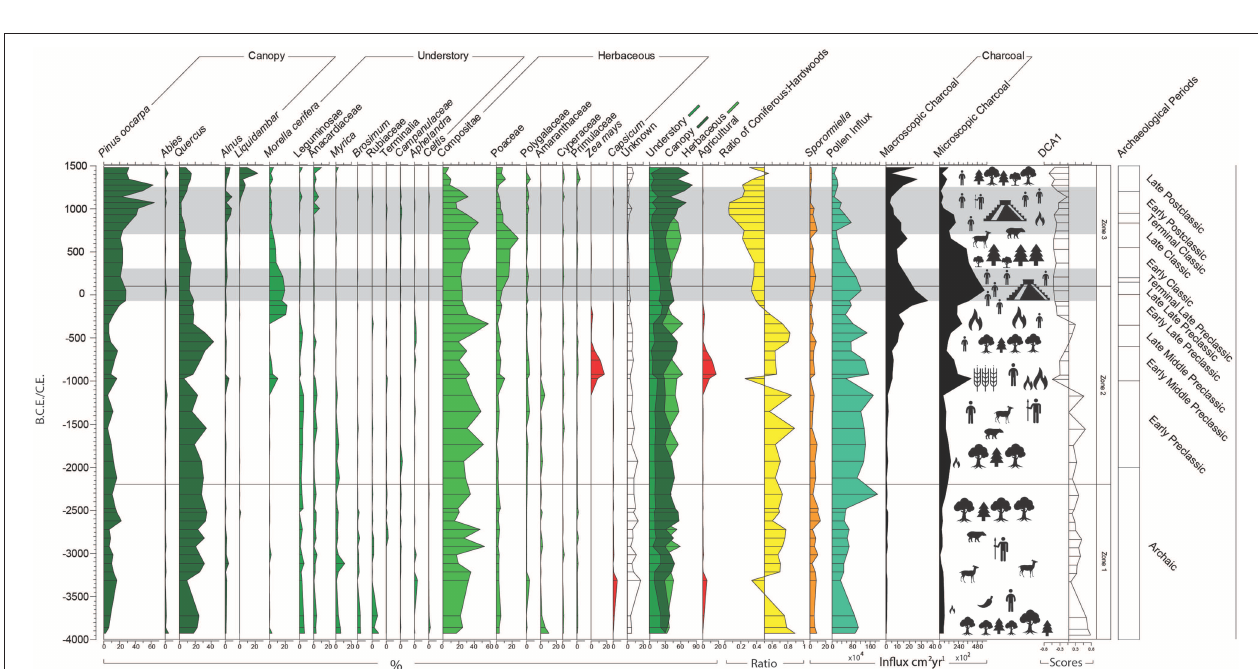
FIGURE 5 | Palynological percentage diagram of taxa appearing in an abundance > 2%; forest structure; coniferous to hardwood ratio; pollen influx; macroscopic and microscopic influx; DCA axis 1; and Occupation of Chinkultic (dark bands). The palynological data are expressed as a percentage of total land pollen.